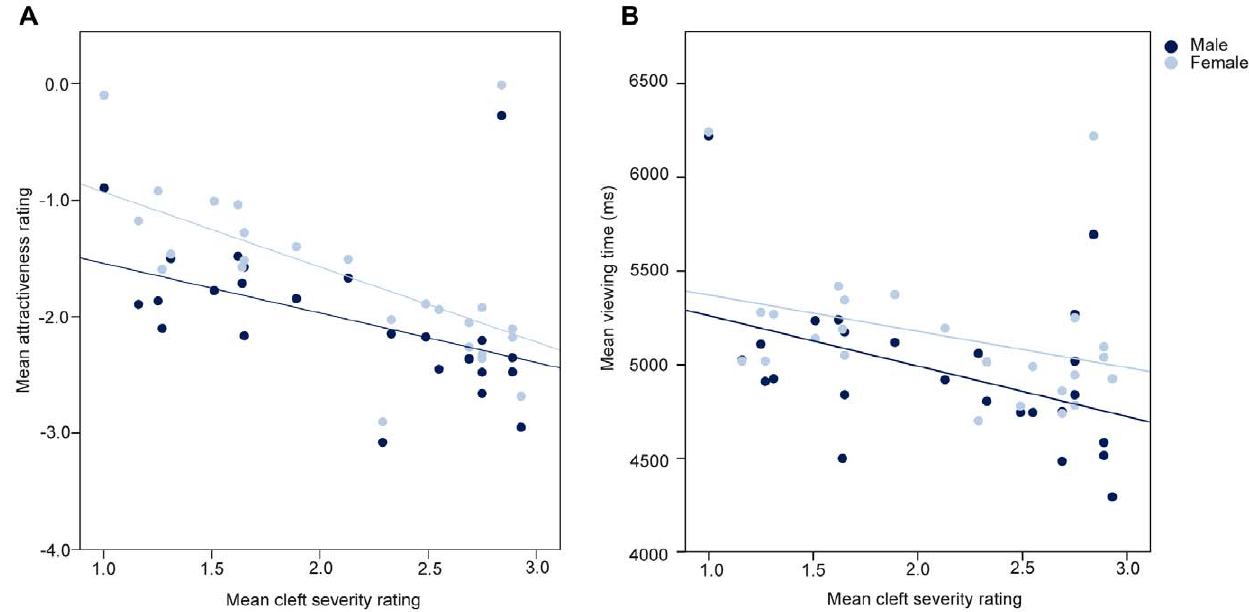
Figure 3. There was a significant correlation between previous ratings of cleft severity (1=mild, 2=moderate, 3=severe) and participants’ attractiveness ratings and viewing times of each infant